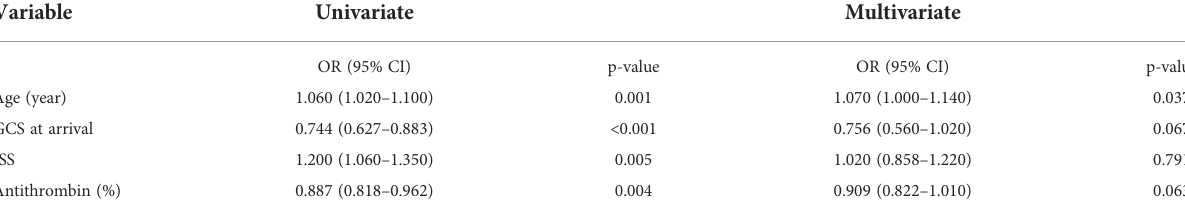
TABLE 4 Univariate and multivariate logistic regression analyses of antithrombin 1 h after injury and other severity scores.